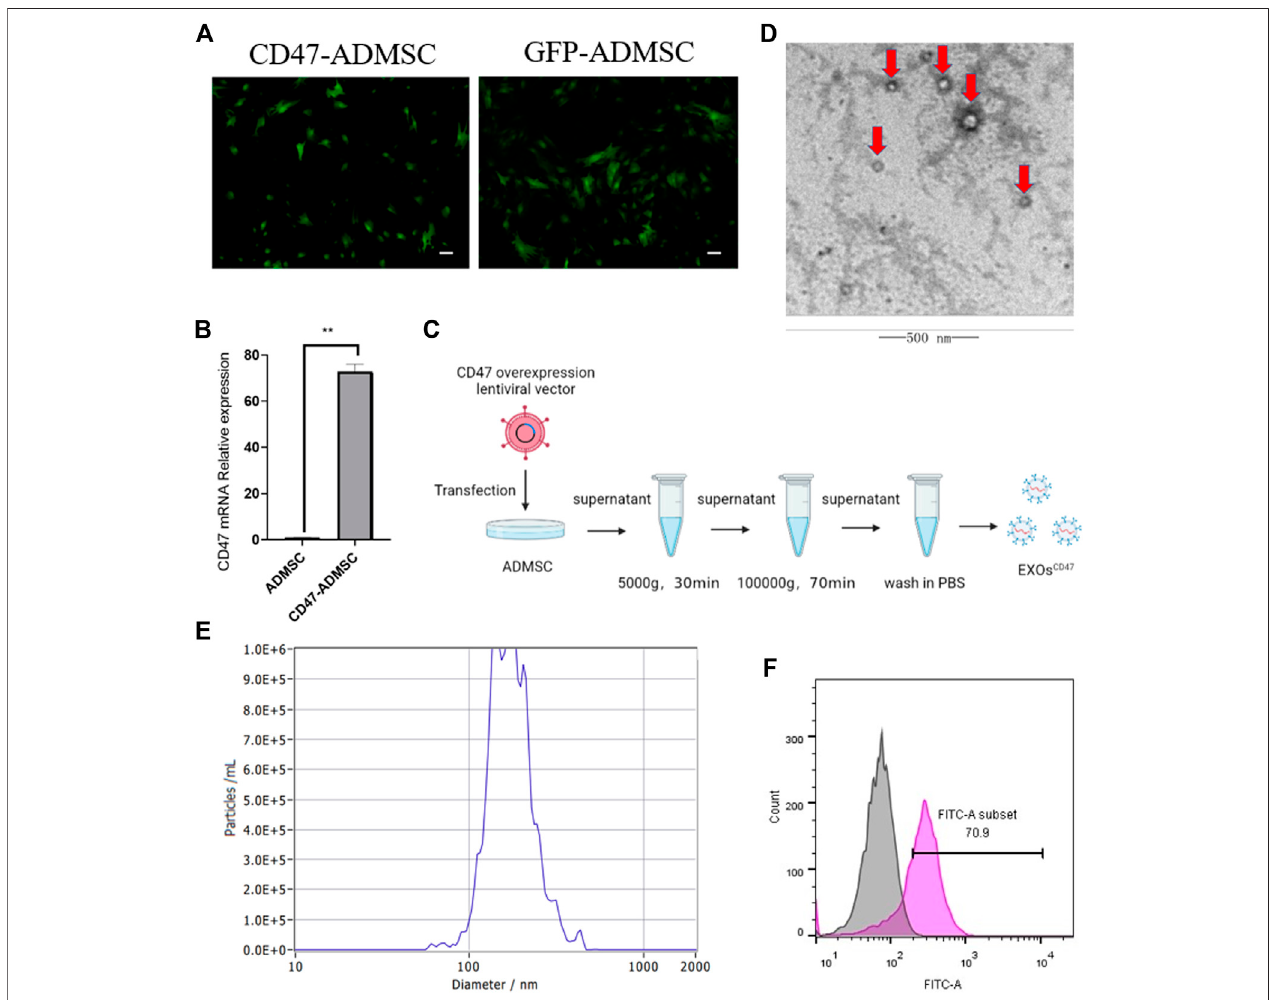
FIGURE 2 | (A) Fluorescence microscopy of ADMSCs with the CD47 overexpression lentiviral vector at the fi fth passage after transfection and GFP-ADMSCs (positivecontrol).Scalebar:500 μ m. (B) Relativeexpression(qPCR)ofCD47inADMSCsandCD47-ADMSCsatthe fi fthpassageaftertransfection.N=3,** p < 0.01. (C) Experimental procedure used to extract EXOs. (D) Electron microscopy of EXOs produced by ADMSCs (red arrows). Scale bar: 500 nm (E) Size distribution of EXOs produced by ADMSCs. (F) Nano fl ow cytometry of CD47 expression by EXOs CD47 . Pink: EXOs CD47 ; Grey: